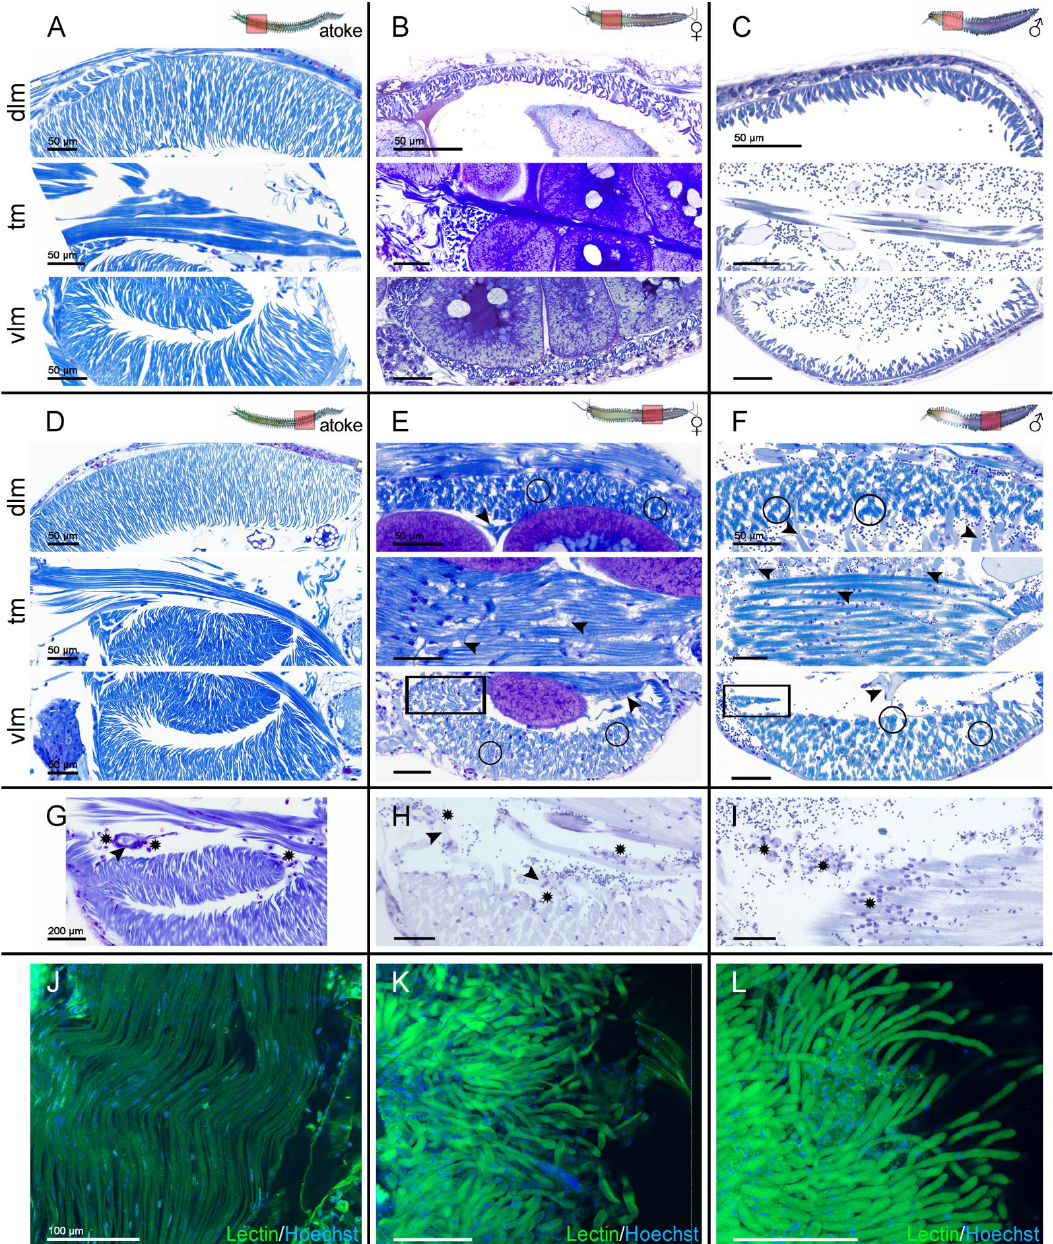
Figure 3. Histological analysis of the remodeling of the different muscle groups. ( A – F ) Toluidine blue-stained semi-thin sections of segmental parts derived from cross-sections with magnifications of the main muscles types ( A , D ) in atokous, ( B , E ) in female, as well as ( C , F ) in male epitokous animals in ( A – C ) anterior and ( D – F ) posterior-located segments of the same worm. ( A , D ) The atokous musculature consists of the dorsal (dlm) and ventral longitudinal muscles (vlm), as well as the transversal muscles (tm) shown in one hemisegment. ( B , C , E , F ) Longitudinal and transversal muscles are differently remodeled during maturation in dependency to their anterior-posterior position along the body axis. ( B , C ) In the anterior segments, the fibers of the dlm and vlm muscles apparently detach from the basement membrane, drop into the coelom cavity, and are greatly reduced in size, so that their total thickness at the end of the metamorphosis is much smaller in both sexes, while the transversal muscles appear unchanged. ( E , F ) The dlm and vlm muscles are also reduced in size and density in posterior-located segments of both sexes, but exhibit additional bundling (circles) of mus- cle fibers and a massive amount of blood vessels (arrowheads). Only the double layered part of the vlm (rectangles) is remodeled like the anterior-located vlm muscles. In contrast, the transversal mus- cle complex displays a swollen overall morphology. ( G – I ) Small eleocytes (asterisks) invade the